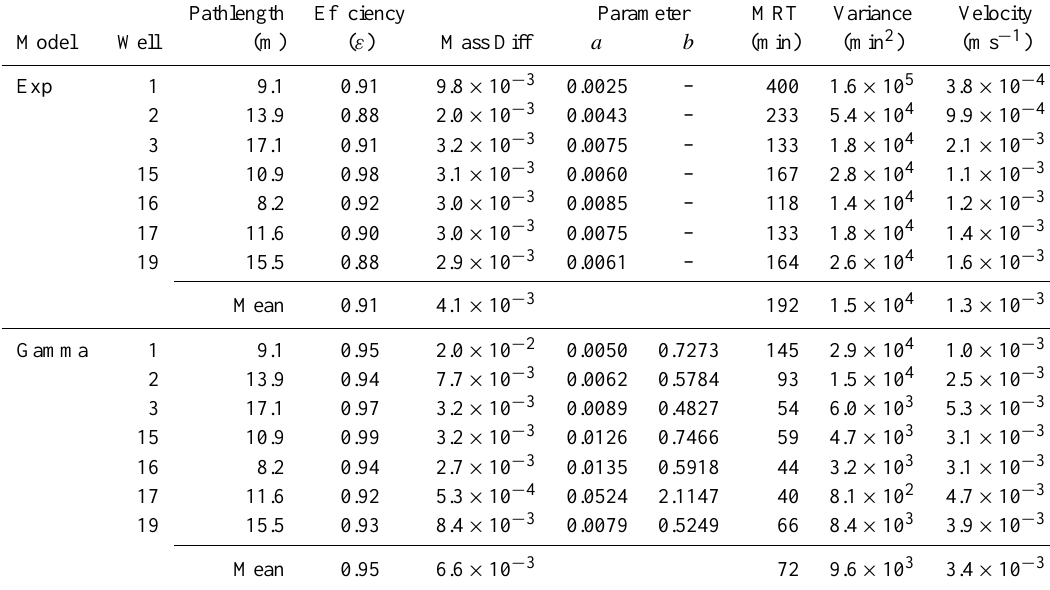
Table 3. Modeling results of pressure transport for salt-added test. The best-fit value for the time delay parameter d was zero for all tests. Negative values of Mass Diff (proportional mass difference) indicate an over-prediction of mass in the tails of residence time